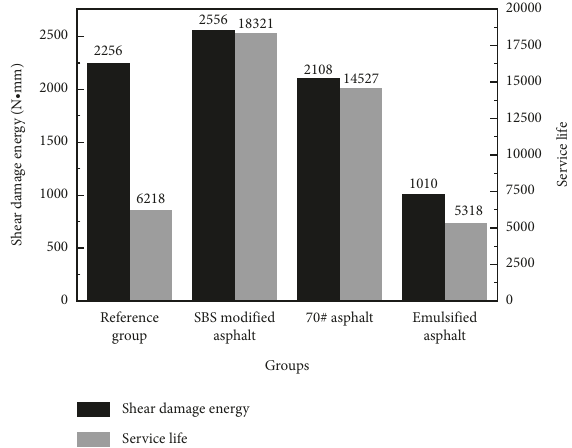
Figure 9: Comparison of shear damage energy and service life for different specimens.